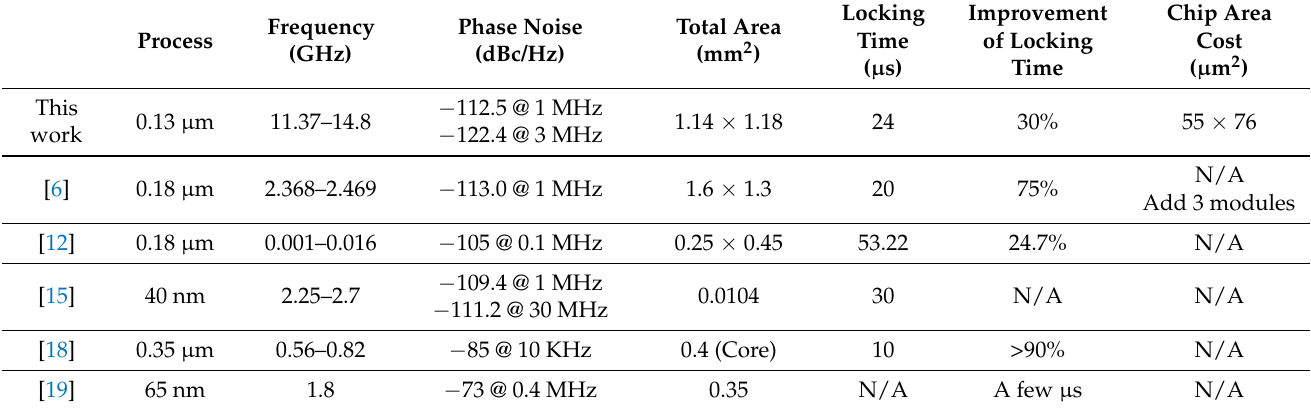
Table 1. Summary and compare of measurement performance of these frequency